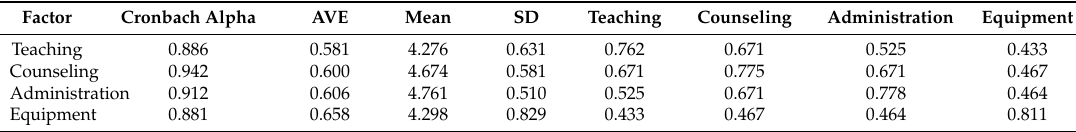
Table 3. Reliability and validity